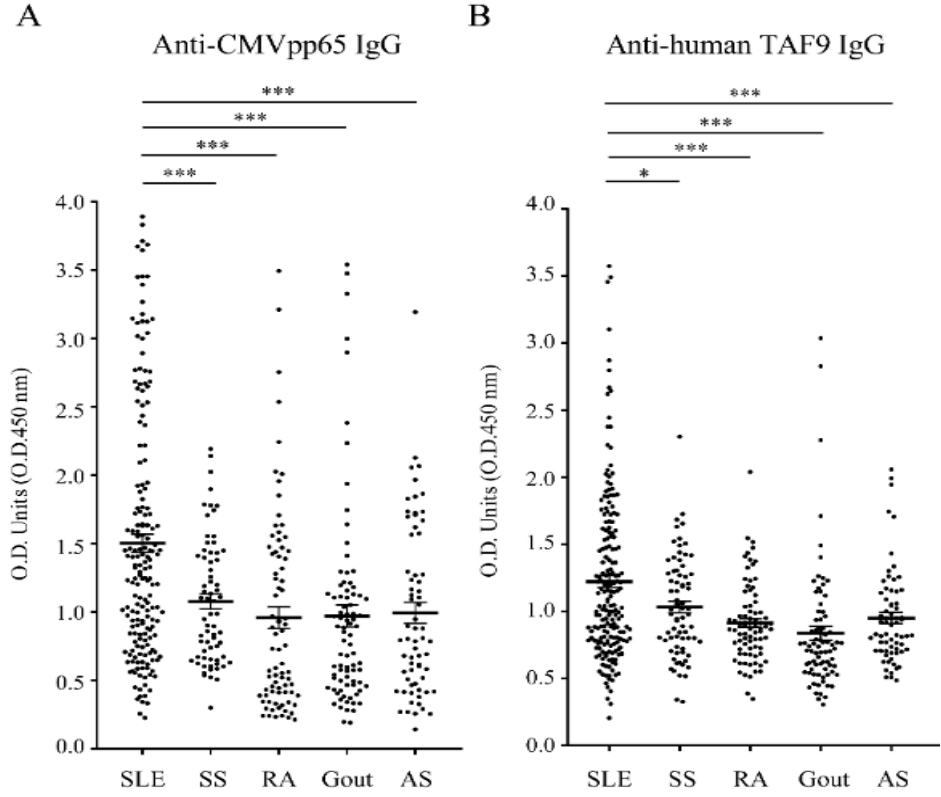
Figure 2. ELISA analysis of the antibody responses to CMVpp65 and TAF9 using sera of patients with SLE ( n = 193), SS ( n = 70), RA ( n = 84), gout ( n = 92), and AS ( n = 68). ( A ) Anti-CMVpp65 IgG activity. ( B ) Anti-human TAF9 IgG activity. * p ≤ 0.05; ** p ≤ 0.01; *** p ≤ 0.001. SLE sera (37.4% and 30.7%) exhibited the highest seropositive rate for anti-CMVpp65 IgG and anti-TAF9 IgG when compared to the sera from AS (32.7% and 11.5%) and SS